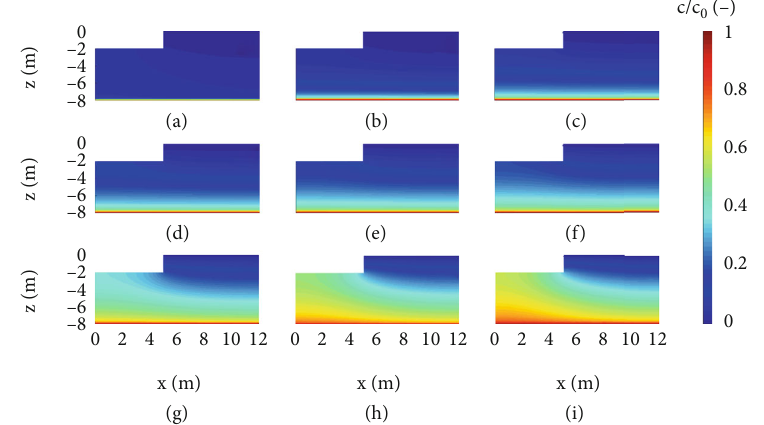
Figure 3: Transient distributions of gaseous TCE concentration in the vadose zone at t =(a) 0d, (b) 10 d, (c) 20 d, (d) 30d, (e) 40 d, (f) 50d, (g) 100 d, (h) 200 d, and (i) 400d, where the groundwater table is located 8m below the ground surface, and the amplitude and period of the fl uctuation are 0.2m and one day, respectively.